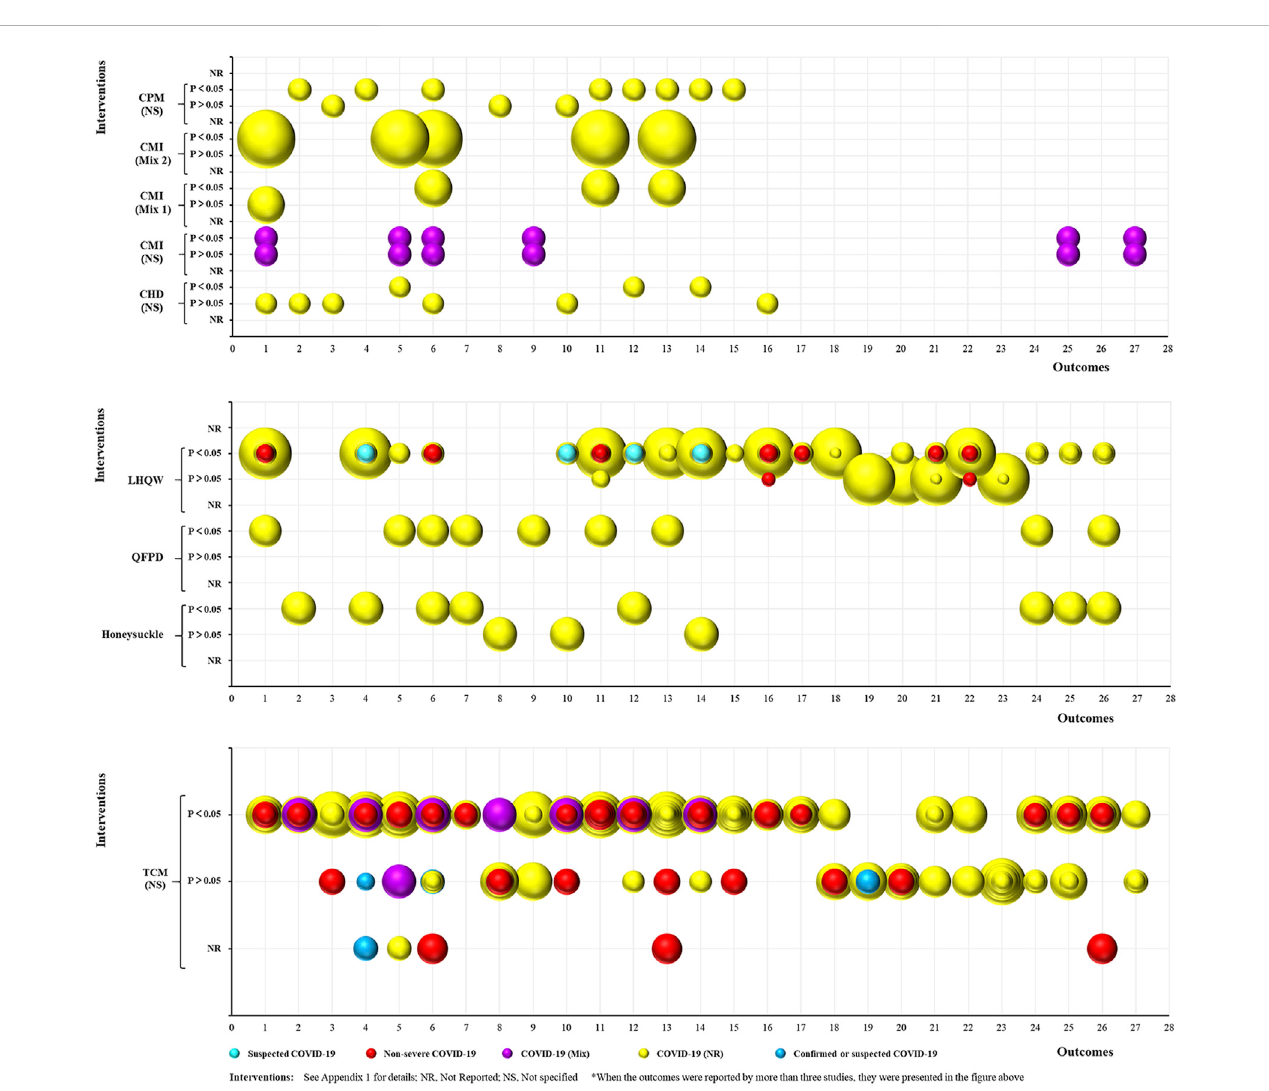
FIGURE 5 Evidence mapping of TCM intervention in COVID-19 treatment SRs. Outcome codes: Total Effective Rate (1); Clinical cure rate (2); Mortality rate (3); Disease aggravation rate (4); Duration of hospitalization (5); Chest CT manifestations (6); TCM syndrome score (7); Viral nucleic acid negative conversion rate (8); Time to viral assay conversion (9); Fever recovery rate (10); Time to fever recovery (11); Cough recovery rate (12); Time to cough recovery (13); Fatigue recovery rate (14); Time to fatigue recovery (15); Rate of shortness of breath recovery (16); Sputum disappearance rate (17); Rate of muscle pain disappearance (18); Rate of sore throat disappearance (19); Diarrhea disappearance rate (20); Anorexia disappearance rate (21); Rate of chest tightness disappearance (22); Nausea/vomiting disappearance rate (23);and In fl ammatory biomarkers: WBC (24), LYM (25), CRP (26), and IL-6